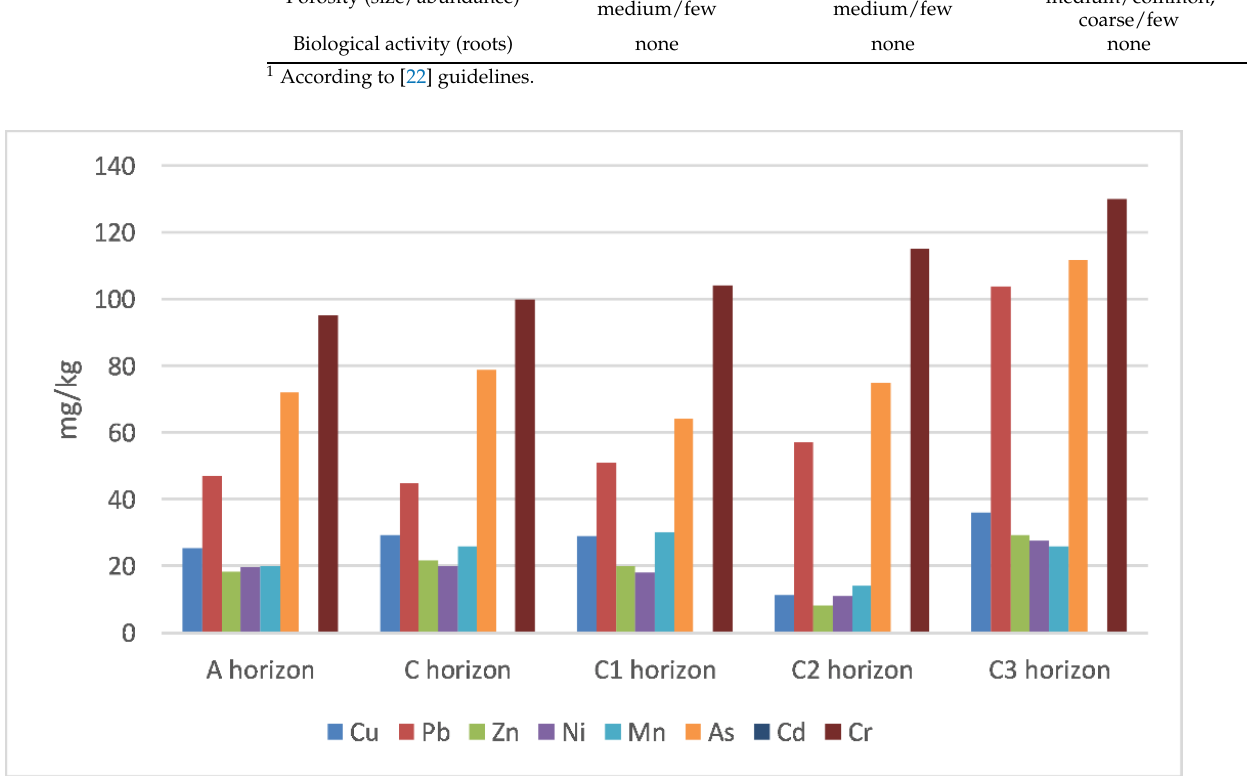
Figure 3. PTE concentrations in soil horizons from São Pedro da Cova mine waste pile. The most abundant elements present in the waste pile samples were Al (up to a maximum of 14.09 wt.% in the C3 horizon), followed by Fe (with a maximum of 4.83 wt.% in the C2 horizon), and K (with a maximum 3.06 wt.% in the C3 horizon). The overall geochemical features of the A horizon and C horizon were similar to the C1 horizon, and the upper layer in the soil was affected by self-burning. The more intensively combusted C2 and C3 horizons showed an increase in Al, Fe, and K when compared to the less burned C1 horizon and A and C horizons, due to mineral changes during combustion and also to the loss of fossil organic matter. Additionally, the horizons affected by self-burning showed an increase of S, especially the C2 horizon. Previous studies [10] have shown similar results, that is, the burned material from the Douro Coal Basin generally presents an increase in Al, Fe, K, and Ti. Regarding trace elements, some contrasts between the coal waste material with normal pedogenesis and the material affected by self-burning have been identified (see Table 3). The C3 horizon had higher concentrations in several trace elements in comparison with the A and C horizons: Ba, with 866 mg/kg (versus 512 and 523 mg/kg in the A and C horizons, respectively); Pb, with 103.7 mg/kg (while the A and C horizons registered 47.0 and 44.9 mg/kg, respectively); As, with 111.8 mg/kg (whereas the A and C horizons showed 72.0 and 78.9 mg/kg, respectively); Sr, with 202 mg/kg (while horizons A and